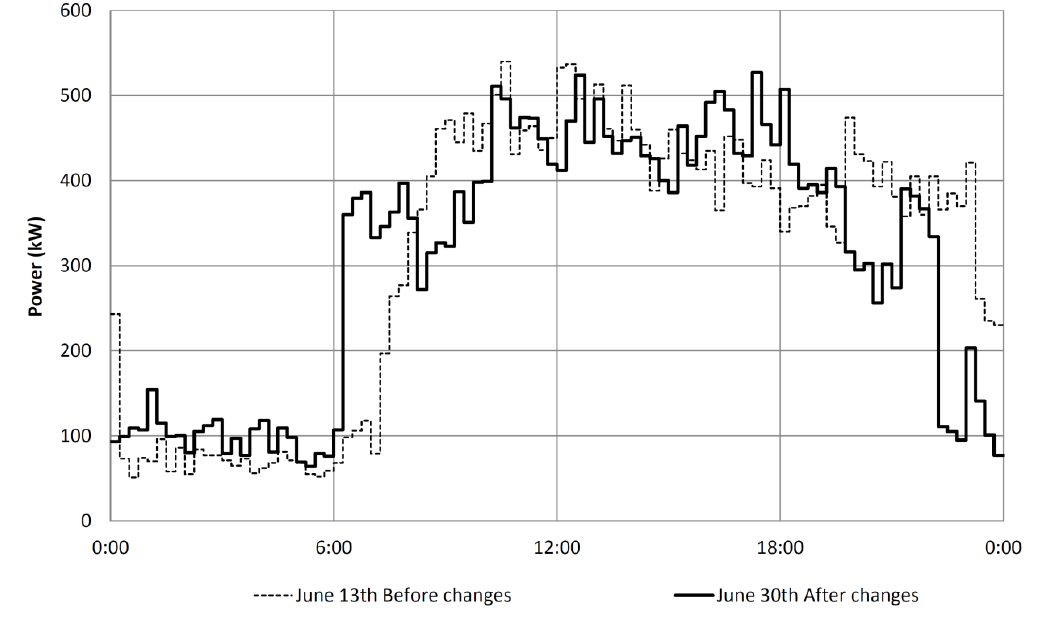
Figure 12. Greenhouses building 8I–8J consumption before and after the EEM.